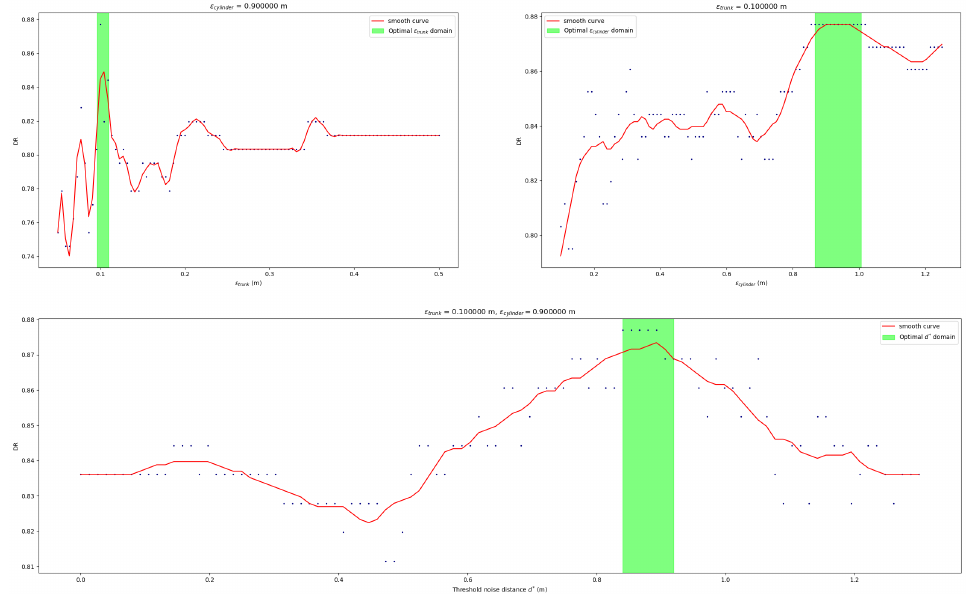
Figure 17. Sensibility analysis of the different input